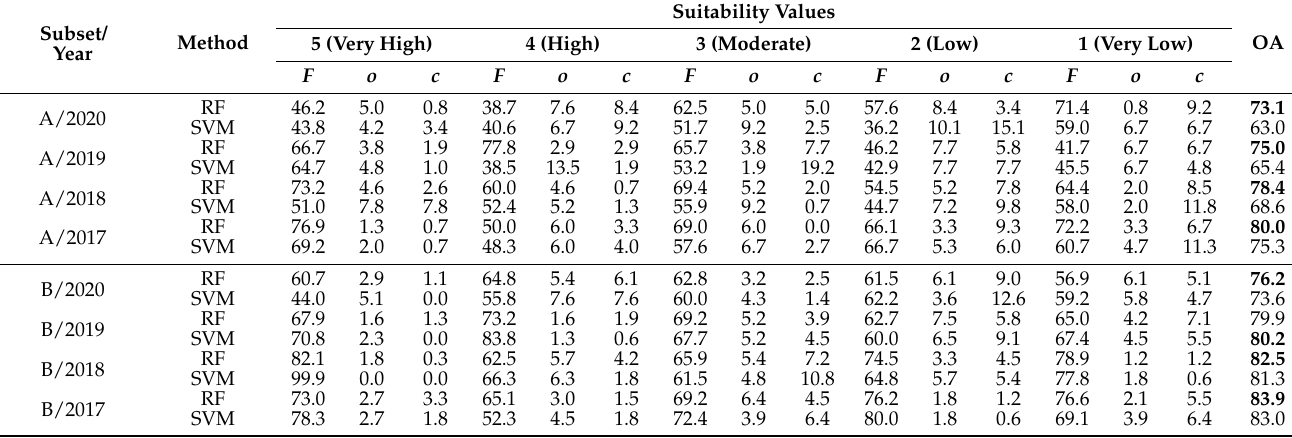
Table 5. Accuracy assessment of cropland suitability values prediction using machine learning methods. Subset/ Year